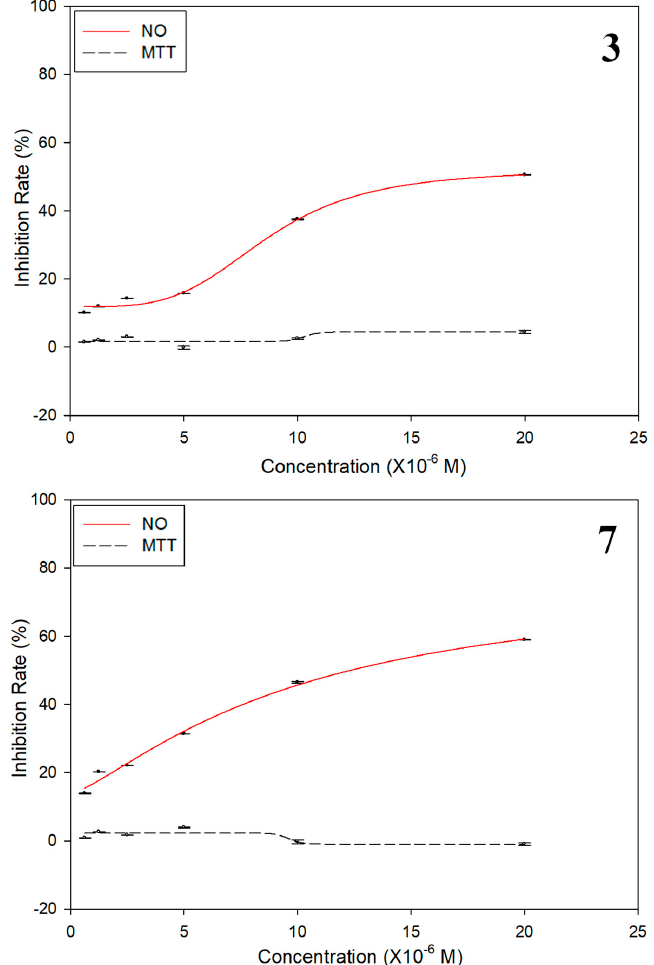
Figure 3. IC 50 values of compounds 3 and 7 on NO production in LPS-induced Raw 264.7 cells. (Raw 264.7 cells were subjected to compounds 3 and 7 with six different concentrations and incubated for 2 h firstly, and then stimulated by adding LPS for 24 h. Then, Griess reagents I and II were added to cell supernatants to detect the NO production levels. The cytotoxicity against macrophage Raw 264.7 cells of compounds 3 and 7 were investigated using the MTT method; NO: Inhibition rates of NO release (%); MTT: Inhibition rates of cell viability